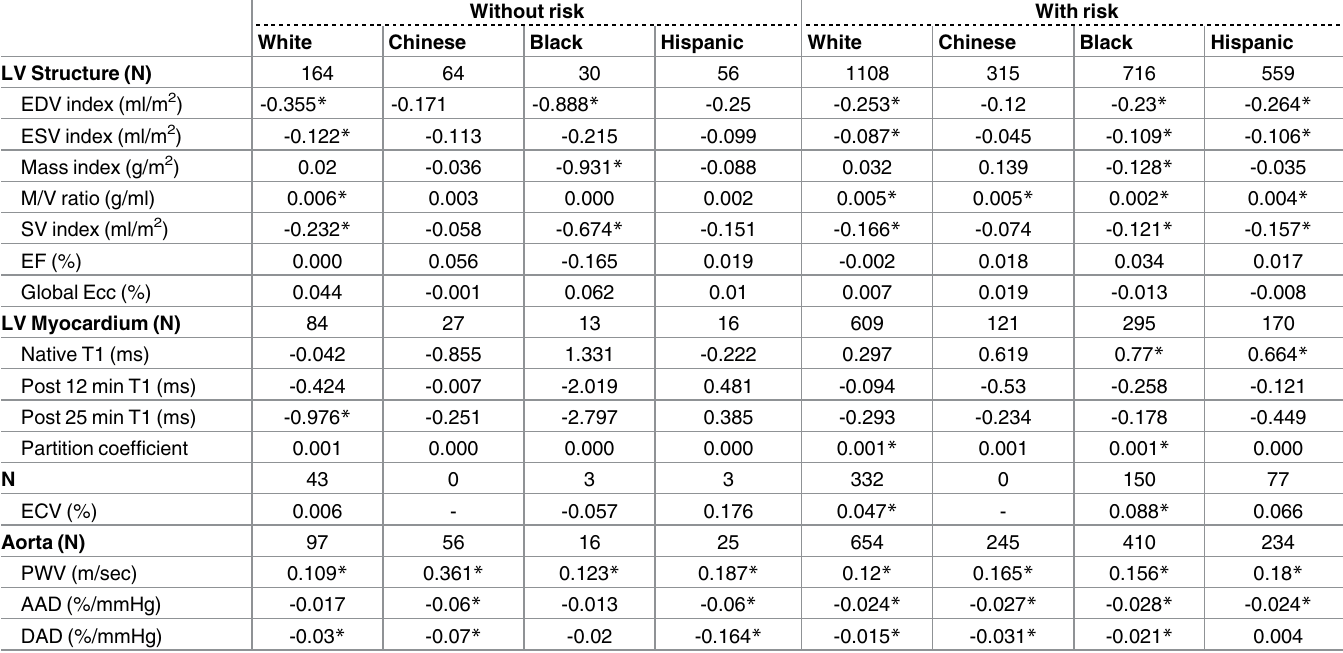
Table 4. The relationship of age with left-ventricular(LV) structure/function and aortic function stratified by with and without traditional risk fac- tors and race/ethnicity. Univariateregression coefficient which representschange in the dependent variableper one-yearincreasein age. * for p < 0.05. Without risk With risk White Chinese Black Hispanic White Chinese Black Hispanic